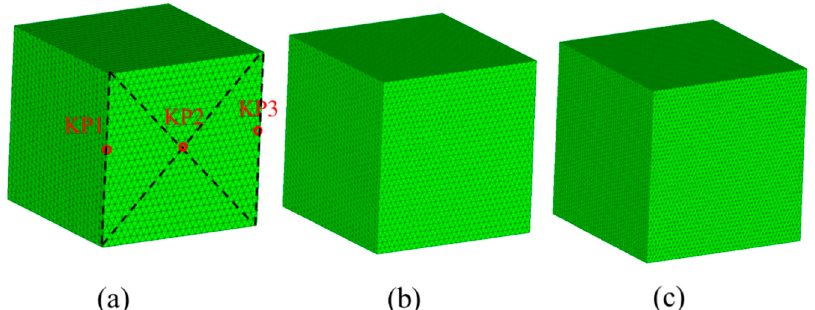
Figure 18. Three di ff erent mesh configurations with di ff erent mesh density: ( a ) Mesh I ( L e = 1 mm), ( b ) Mesh II ( L e = 0.8 mm), ( c ) Mesh III ( L e = 0.6 mm). Figure 18. Three different mesh configurations with different mesh density: ( a ) Mesh I (